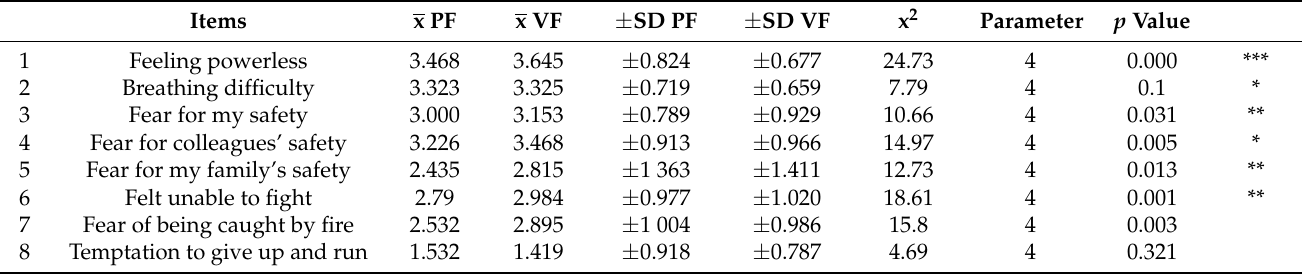
Table 9. Difficulties, emotions, and personal reactions, PF vs. VF firefighter ( n =